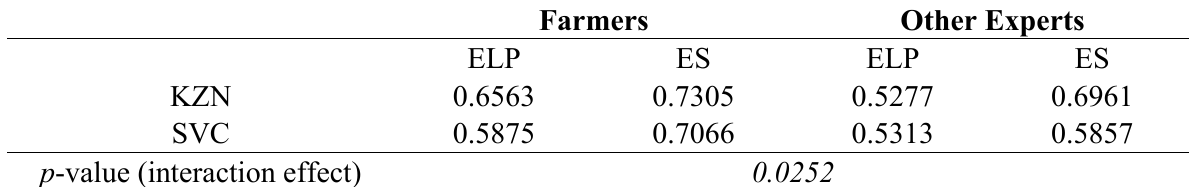
Table 7. Means of ES and ELP sub-indices across sites by stakeholder. ES, Ecosystem Services; ELP, Ecoagriculture Landscape Performance; KZN, KwaZulu-Natal; SVC, Savé Valley